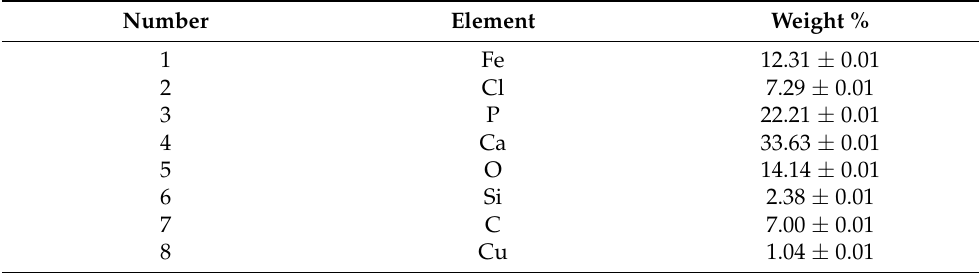
Figure 6. ( a ) SEM and ( b ) TEM images of composite. Table 1. The weight % of composite ingredients based on EDAX analysis.